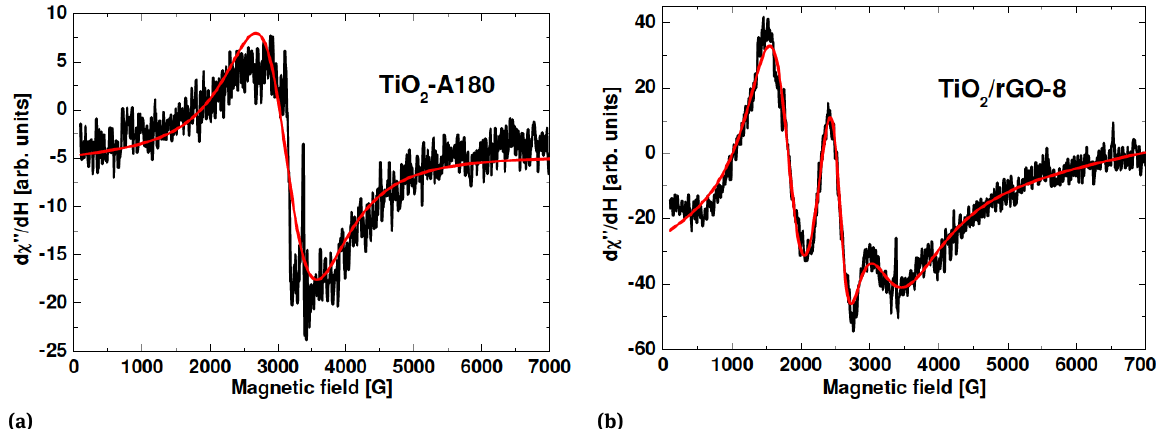
Figure 5: EPR spectra of the nanocomposites at low magnetic field: a) sample TiO 2 -A180 and b) nanocomposite TiO 2 /rGO-8